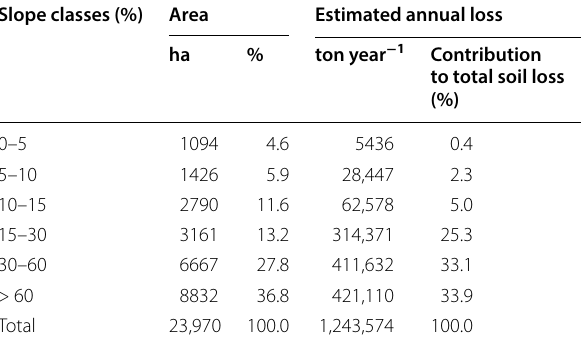
Table 7 Annual values of soil loss for various slope classes of the watershed